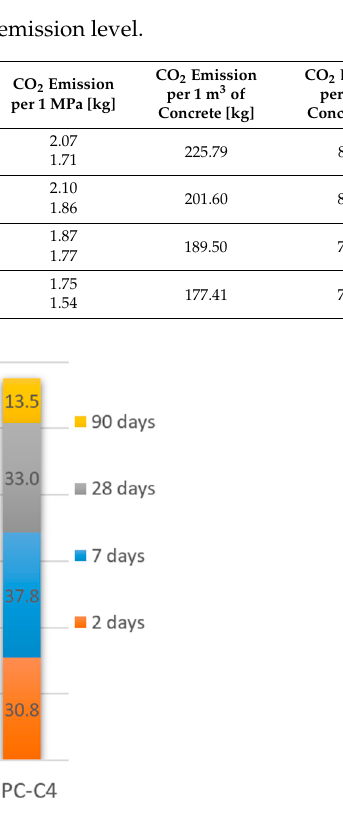
Figure 13. Consistency of SCC concrete mixtures in time. Table 13. Properties of HPC with CO 2 emission level.